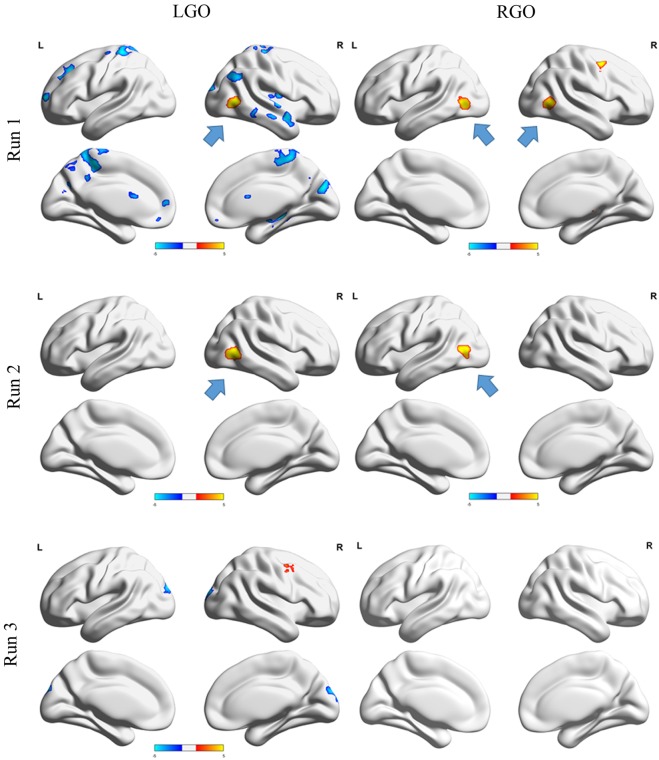
Contrast maps comparing NF and non-NF sessions for runs 1 (top row), 2 (middle row) and 3 (bottom row) for LGO (left column) and RGO (right column) tasks. Regions where NF > non-NF are shown in red-yellow colors, whereas regions where NF < non-NF are shown in dark-light blue colors. Contrast maps were generated using a threshold value of p < 0.05 corrected for multiple comparisons using family wise error correction at the cluster level. Blue arrows indicate the location of left or right middle temporal gyrus/inferior occipital gyrus. LGO, imagined left hand gripping and opening and RGO, imagined right hand gripping and opening.